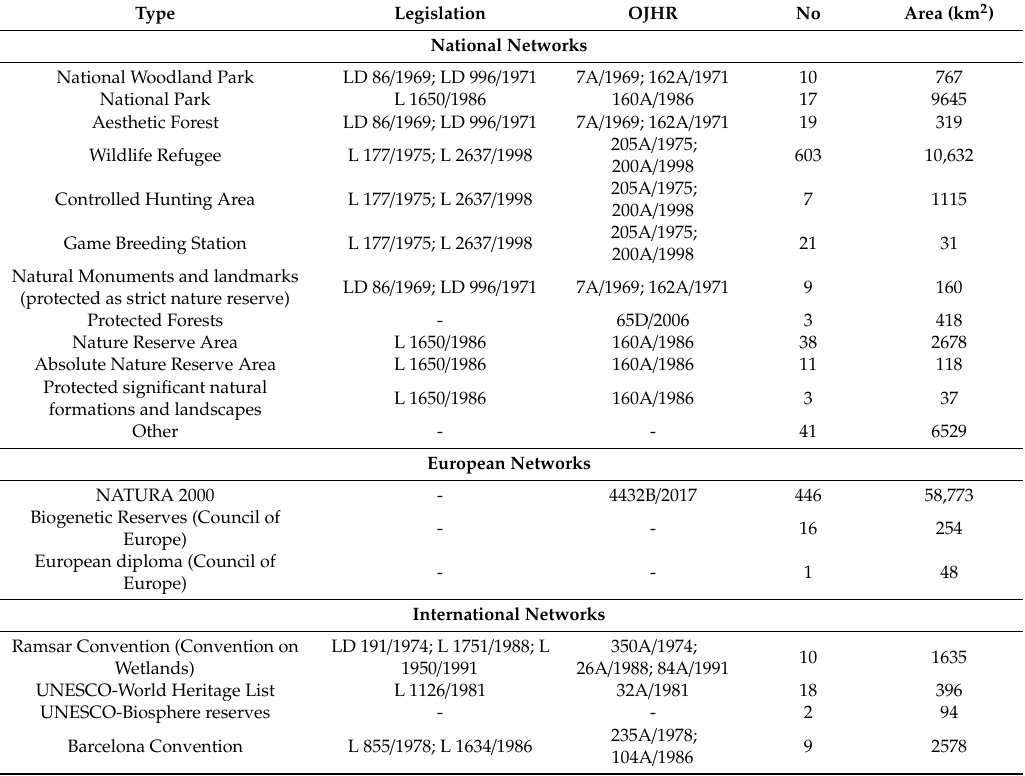
Table 3. Environmental protection networks in Greece.